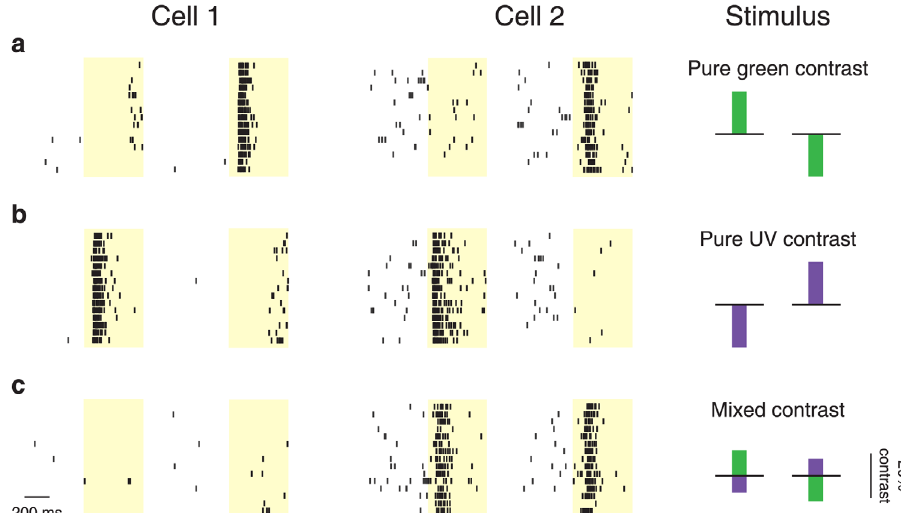
Fig. 1 Linear and nonlinear chromatic integration in the mouse retina. a Raster plots of spike times for two sample Off-type ganglion cells in response to 500-ms presentations (marked by the yellow shaded areas) of green contrast. Each line is a trial, showing for each cell spikes from 500 ms prior to stimulus onset until stimulus offset for both positive contrast (left) and negative contrast (right). Schematic presentations of the chromatic stimulus components are shown in the column on the right. b Responses of the same cells to pure UV stimuli with negative contrast (left) and positive contrast (right). c Responses of the same cells to a stimulus with simultaneous UV and green contrast of opposing signs (mixing the pure-color stimuli from a and b in the same column above) and to the contrast-reversed stimulus. Cell 1 showed cancellation of activation by green and UV contrast (linear chromatic integration), whereas Cell 2 displayed strong activity for both contrast combinations (nonlinear chromatic